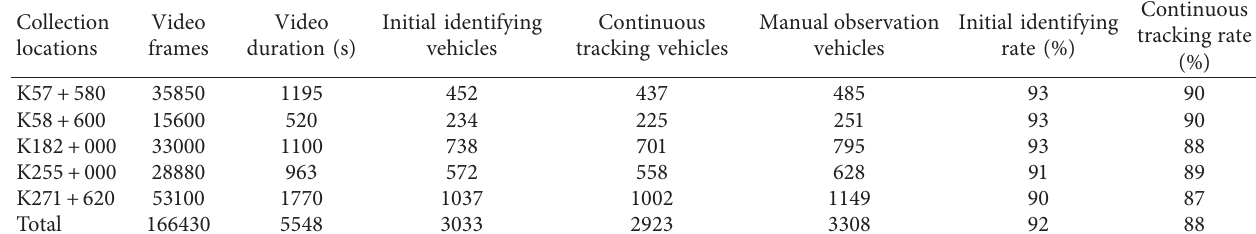
Table 1: Identifying and tracking rate of video recognition program.